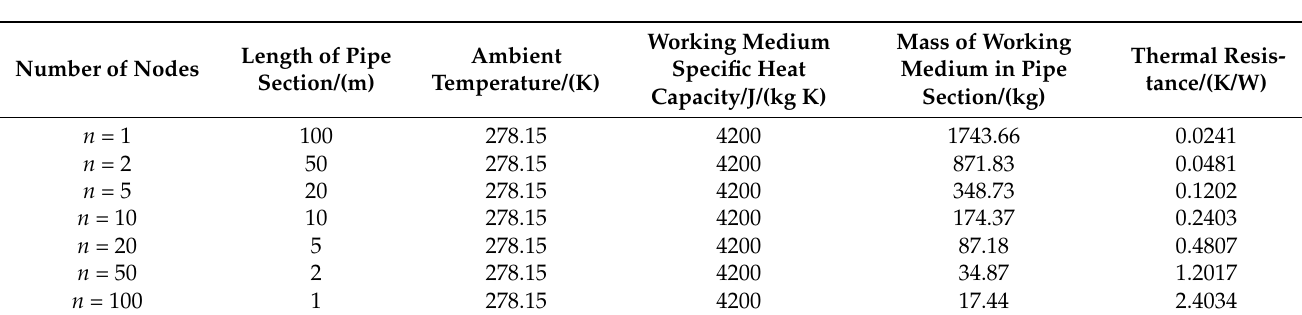
Table 2. Distributed model